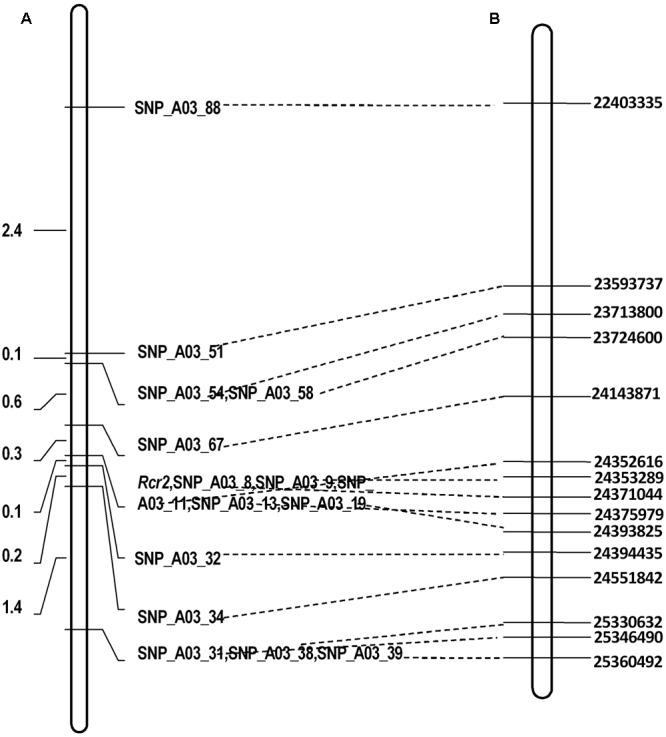
Linkage maps of the regions in which the Rcr2 gene is located. Broken lines drawn regions defined by different molecular markers on B. rapa linkage group A03. (A) Fine mapping of Rcr2 based on a F1 population consisting of 675 plants derived from ACDC × Jazz. The genetic distance is shown on the left. (B) Physical locations in bases (right) of the SNP markers.